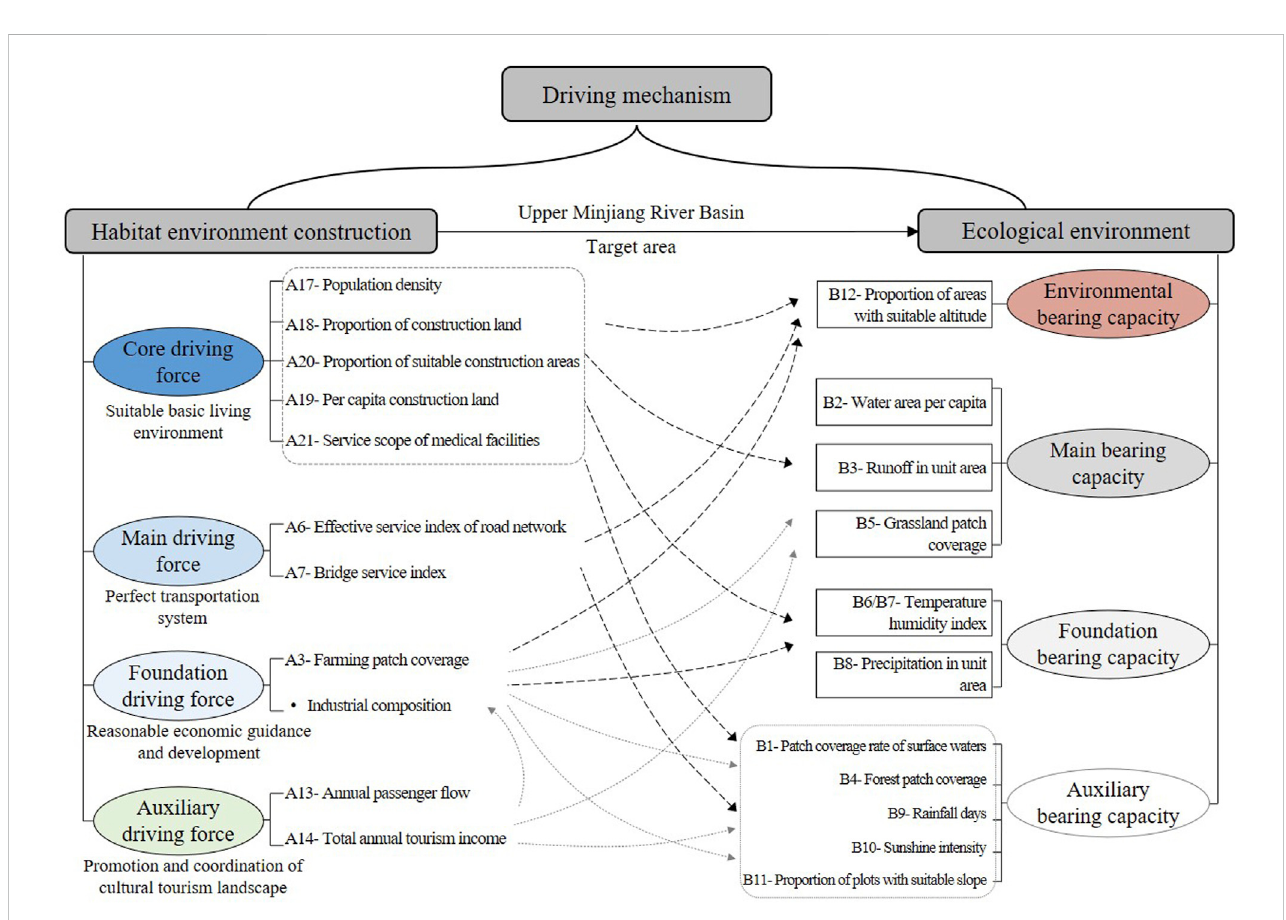
FIGURE 6 “ Habitat-ecology ” driving mechanism